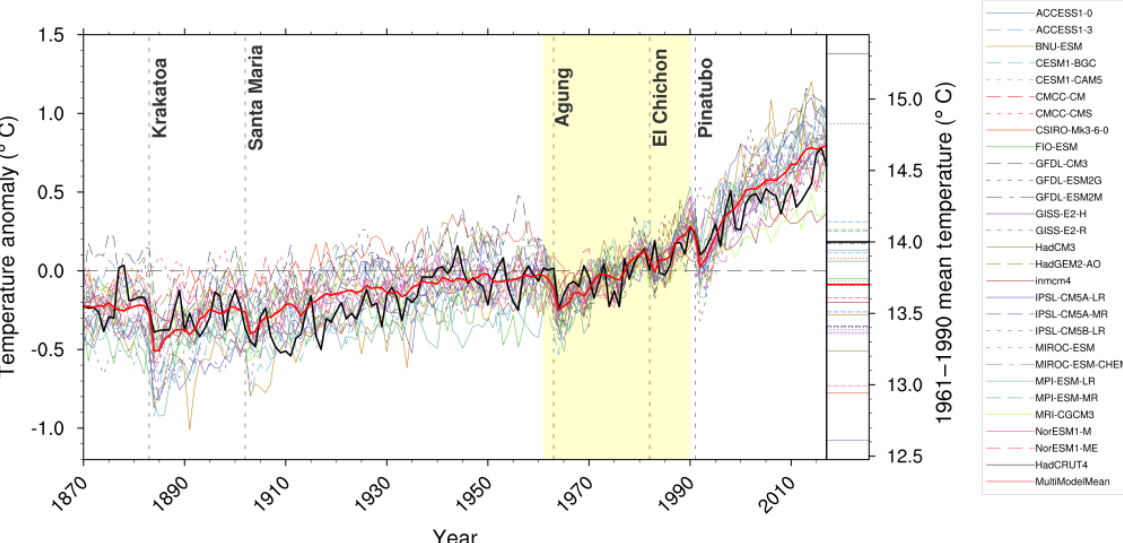
Figure 7. Anomalies in annual and global mean surface temperature of CMIP5 models and HadCRUT4 observations. Yellow shading indicates the reference period (1961–1990); vertical dashed grey lines represent times of major volcanic eruptions. The right bar shows the global mean surface temperature of the reference period. CMIP5 model data are subsampled by the HadCRUT4 observational data mask and processed as described in Jones et al. (2013). All simulations are historical experiments up to and including 2005 and the RCP 4.5 scenario after 2005. Extended from Fig. 9.8 of IPCC WG I AR5 chap. 9 (Flato et al., 2013) and produced with recipe_flato13ipcc.yml ; see details in Sect.